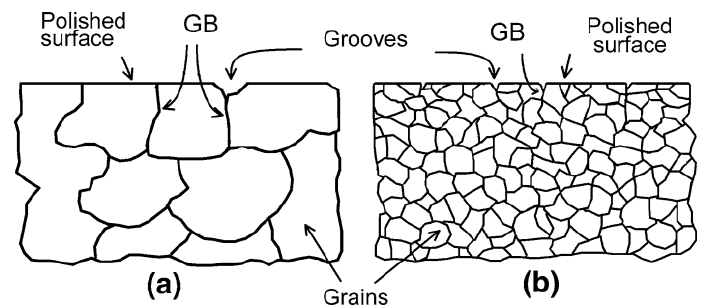
Figure 19. Schematic illustration of the presence of grooves on polished ( a ) coarse-grained and ( b ) nano-grained surfaces reprinted with permission from Ref. [79]. Copyright 2022 Springer.